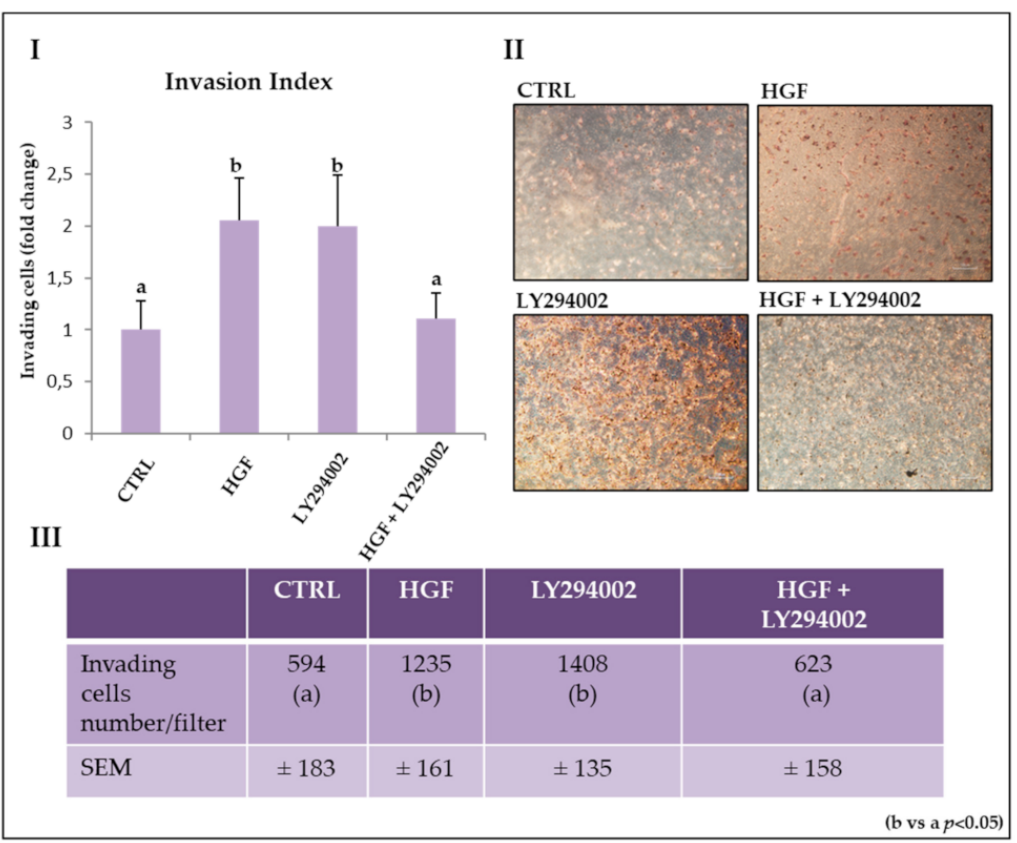
Figure 5. E ff ect of LY294002 on NT2D1 cell invasion. ( I ) Quantitative analysis of invading cells. Results are expressed as fold change ( ± S.E.M.) and the control condition is considered as 1 (b vs. a; p < 0.05). ( II ) Representative phase contrast images of invading cells under di ff erent culture conditions. Images were recovered at 10 × magnification. ( III ) Table illustrating the number of invading cells / filter in all experimental conditions. At least three independent experiments were performed in